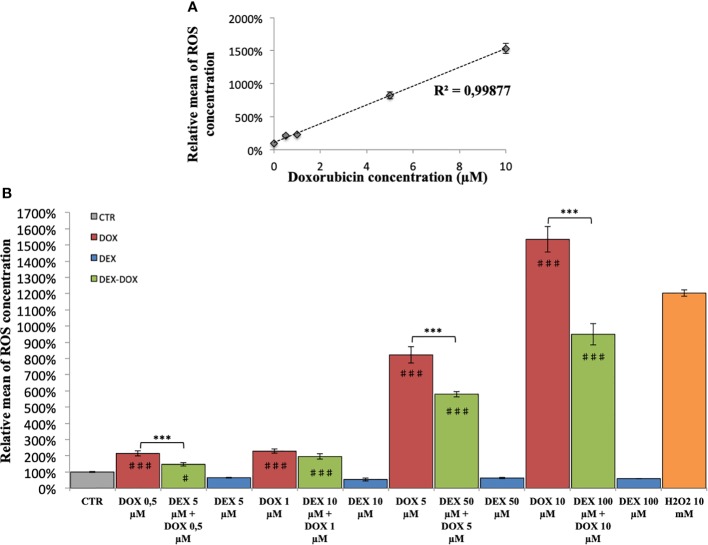
Relative mean of ROS concentration. (A) After 2 hours of exposure to different doses of DOX. (B) Effect of DEX alone treatment and 30 minute pre-incubation on 2 hours exposure to different doses of DOX. One-way ANOVA with multiple comparisons: ***p value < 0.001. ♯: comparison with CTR (p value < 0.05), ♯♯♯: comparison with CTR (p value < 0.001).